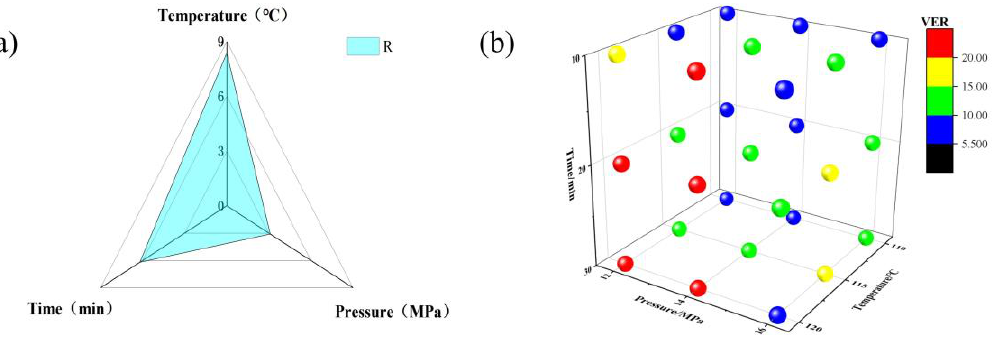
Figure 6. Parallel experiments on PPCE-1.2: ( a ) Orthogonal experiment: R. ( b ) 3D plot of foam VER for three factors.